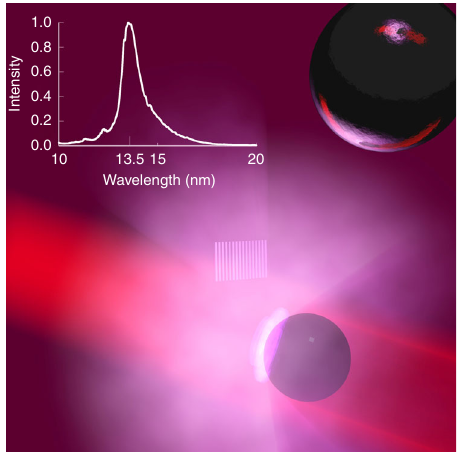
Fig. 1 Generation of extreme ultraviolet light. Laser-produced plasma based on the irradiation of tin (Sn) microdroplets by a high-energy ns- pulsed laser. This hot and dense plasma contains highly charged ions to generate extreme ultraviolet (EUV) light near 13.5 nm wavelength relevant for state-of-the-art nanolithography. A transmission grating spectrometer, set up under a − 60° angle with respect to the laser light propagation direction, enables unraveling the EUV spectrum. Figure by Tremani/